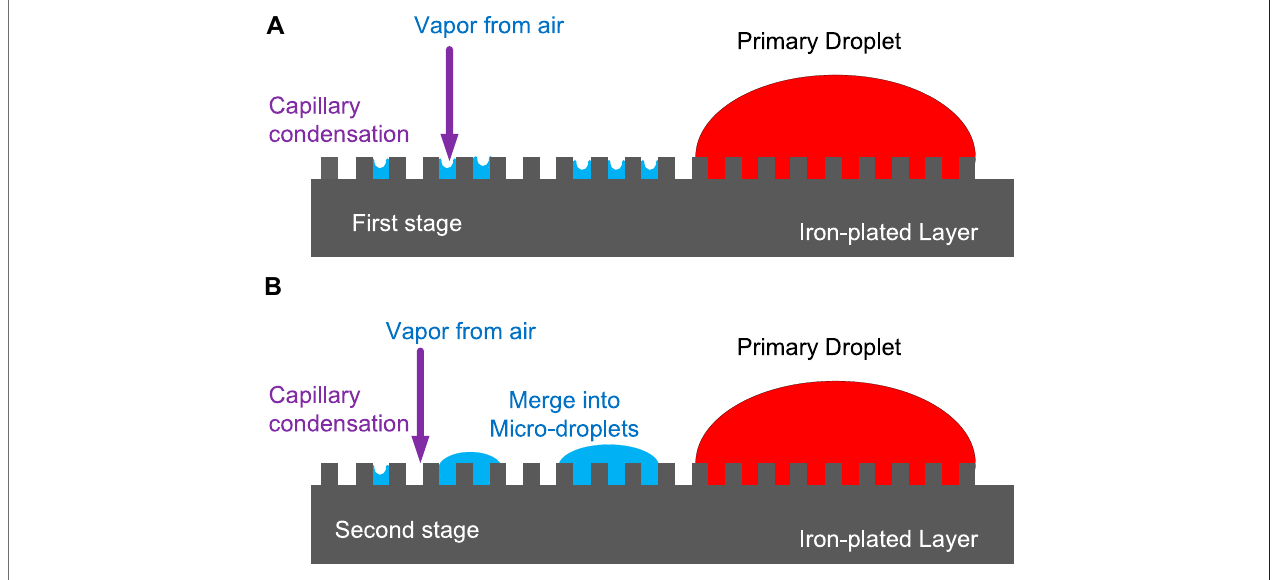
FIGURE 9 | Schematic diagram of nucleation and growth of microdroplets.